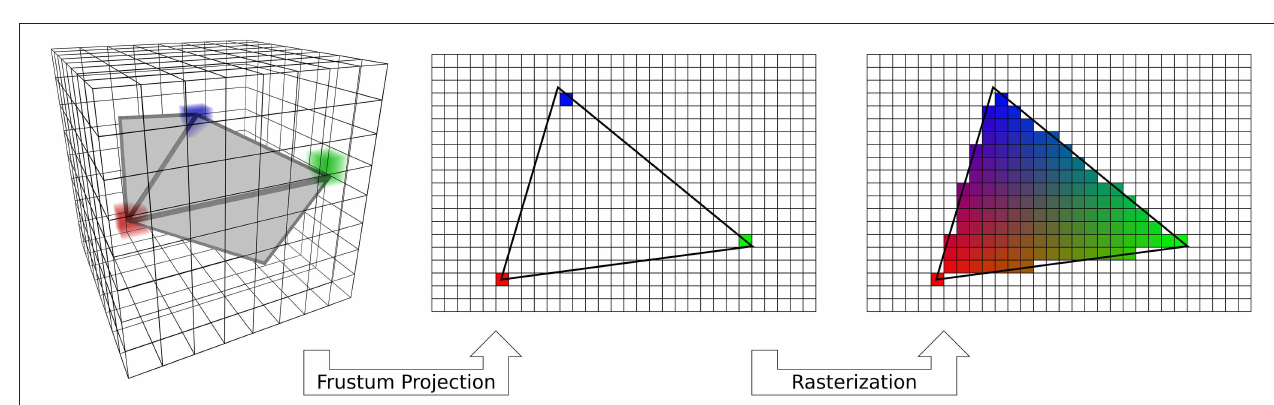
FIGURE 2 | Standard vertex-based mapping. Standard OpenGL rendering implements an algorithm that can be used for vertex-based mapping. First, a fragment of the surface (gray) embedded in the voxel data (3D grid) is used to sample the data. Sampling occurs at only the vertices of the triangle (red, green, blue cubes). The surface triangle is projected to the screen on a regular 2D grid through a standard frustum projection (Woo et al., 1999). Only the data sampled by the vertices are carried over to the screen. Finally, the automatic graphics pipeline rasterizes the triangle by interpolating the colors across a barycentric coordinate space. Vertex-based mapping is generic, but does not adequately sample volumetric